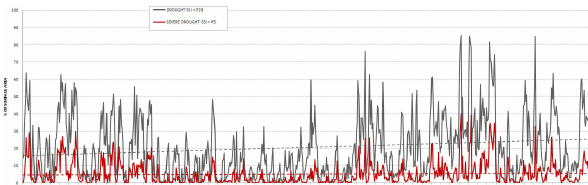
Fig. 7. Temporal evolution of the percentage of affected area by streamflow droughts. The grey line depicts discharges under − 0.84 of the standardized streamflow series. The red line depicts dis- charges under −